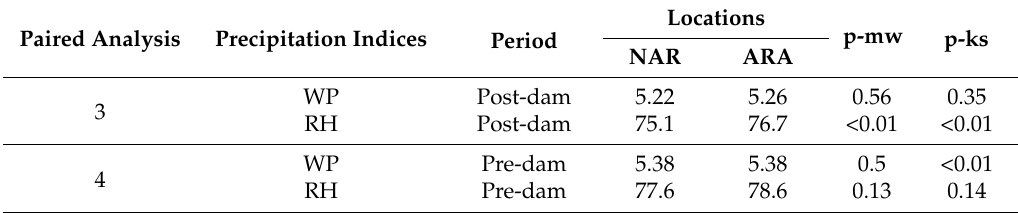
Table 11. Statistical difference tests for the mean and distribution in the RH (%) and WP (hPa) at the same locations for the different locations.